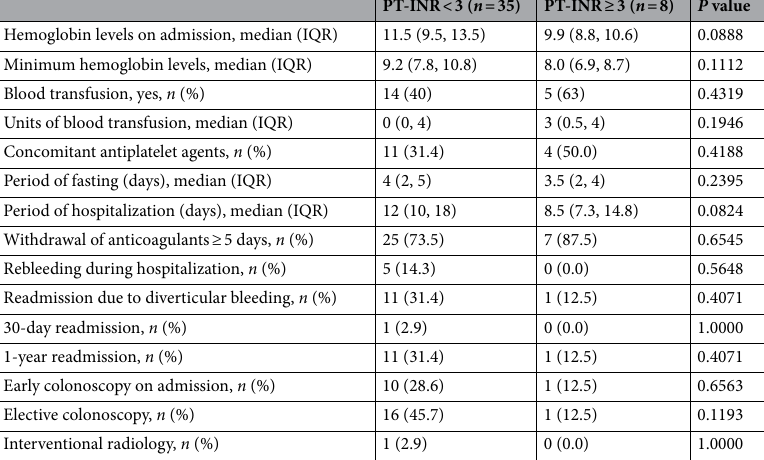
Table 5. Clinical outcomes in warfarin-treated patients with different PT-INR